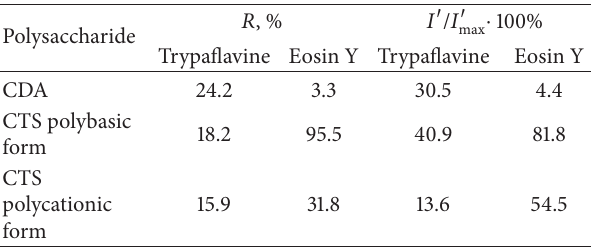
Table 2: The indicators of sorption and fluorescence of the probes on the solid fibrous matrices.